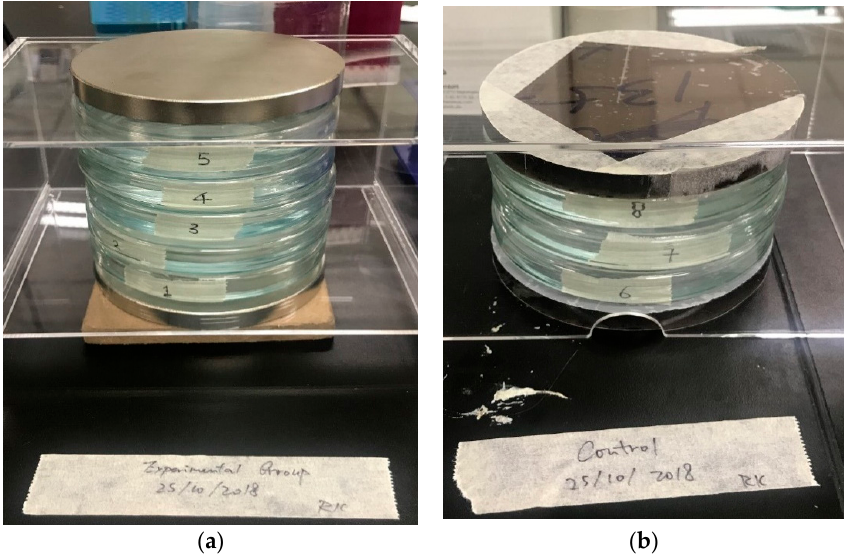
Figure 3. Exposure arrangement of: ( a ) treated groups; ( b ) control groups.